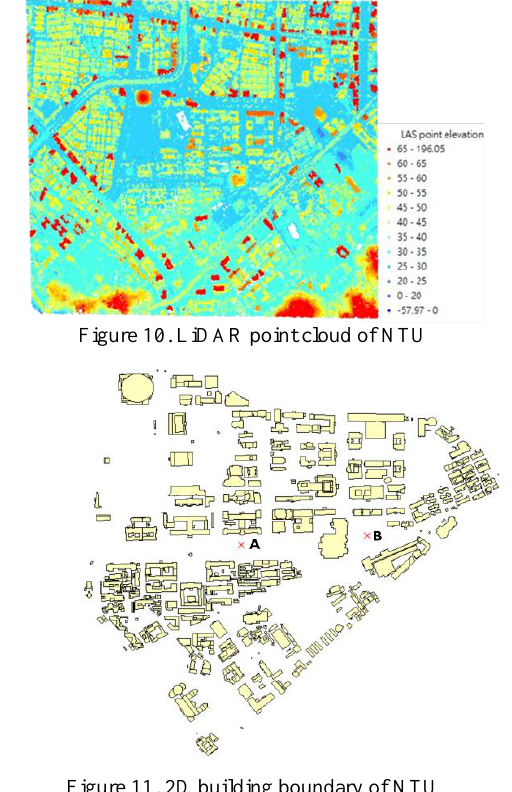
Figure 11. 2D building boundary of